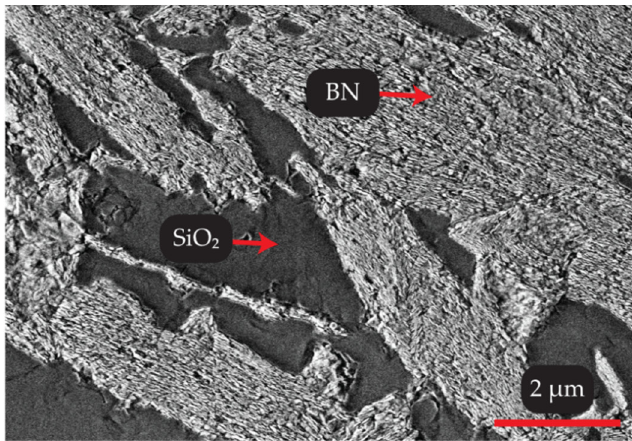
Figure 4. Scanning electron microscopy (SEM) image of grade M26 BN-SiO 2 . The dark regions are amorphous silica (SiO 2 ) and the light regions are orthotropic boron nitride (BN).